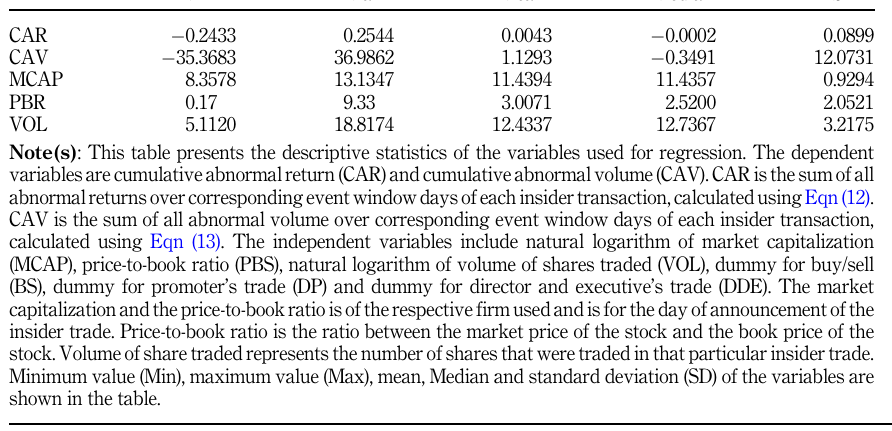
Table 4. Summary